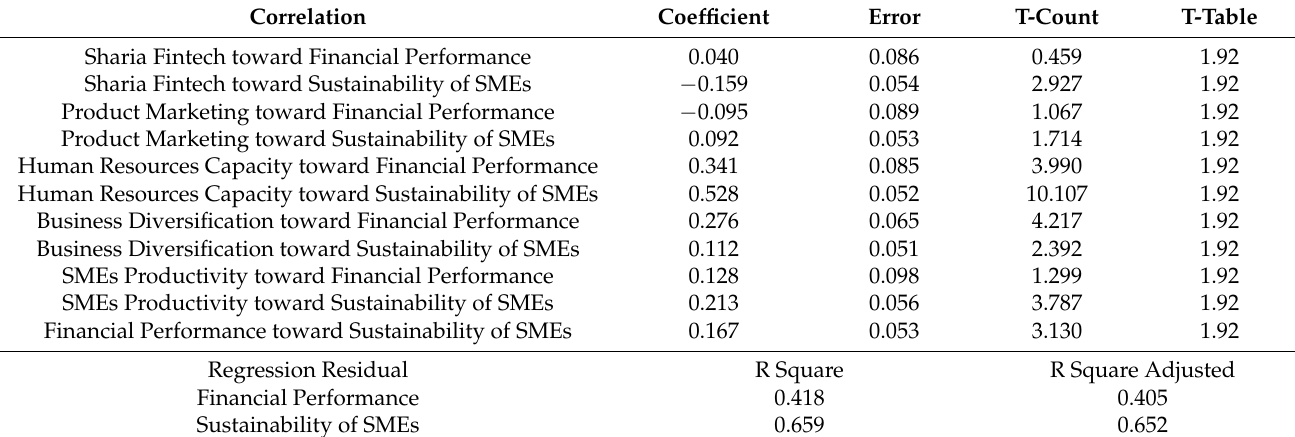
Table 6. Summary of the results of the regression coefficient significance